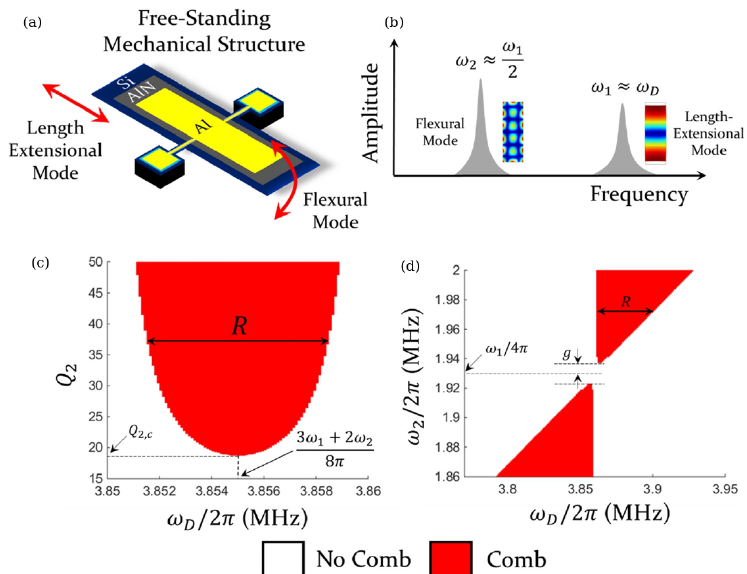
Figure 5. Model of phononic FC generation using nonlinear resonances of a micromechanical resonator. ( a ) Sketch of the model of the micromechanical resonator used in the experiment in [9]. ( b ) Schematic representation of the experimental spectrum in Figure 4a (right) showing a fundamental length-extensional mode of the resonator (the resonance frequency ω 1 ) and its subharmonic flexular mode (the resonance frequency ω 2 ≈ ω 1 /2.) ( c , d ). Graphical representation of the regions, where the generation of FC is possible using the experimental parameters from [9]. Panel ( c ) shows a plot of the quality factor of the mode with ω 2 as a function of the driving frequency ω D . The ω 2 -vs- ω D plot is presented in Panel ( d ). The parameters are ω 1 /2 π = 3.86MHz and Q 1 = 4000 in ( c ) and ω 1 /2 π = 3.86MHz, Q 1 = 4000 and Q 2 = 50 in ( d ). Reproduced from [14] with the permission of AIP